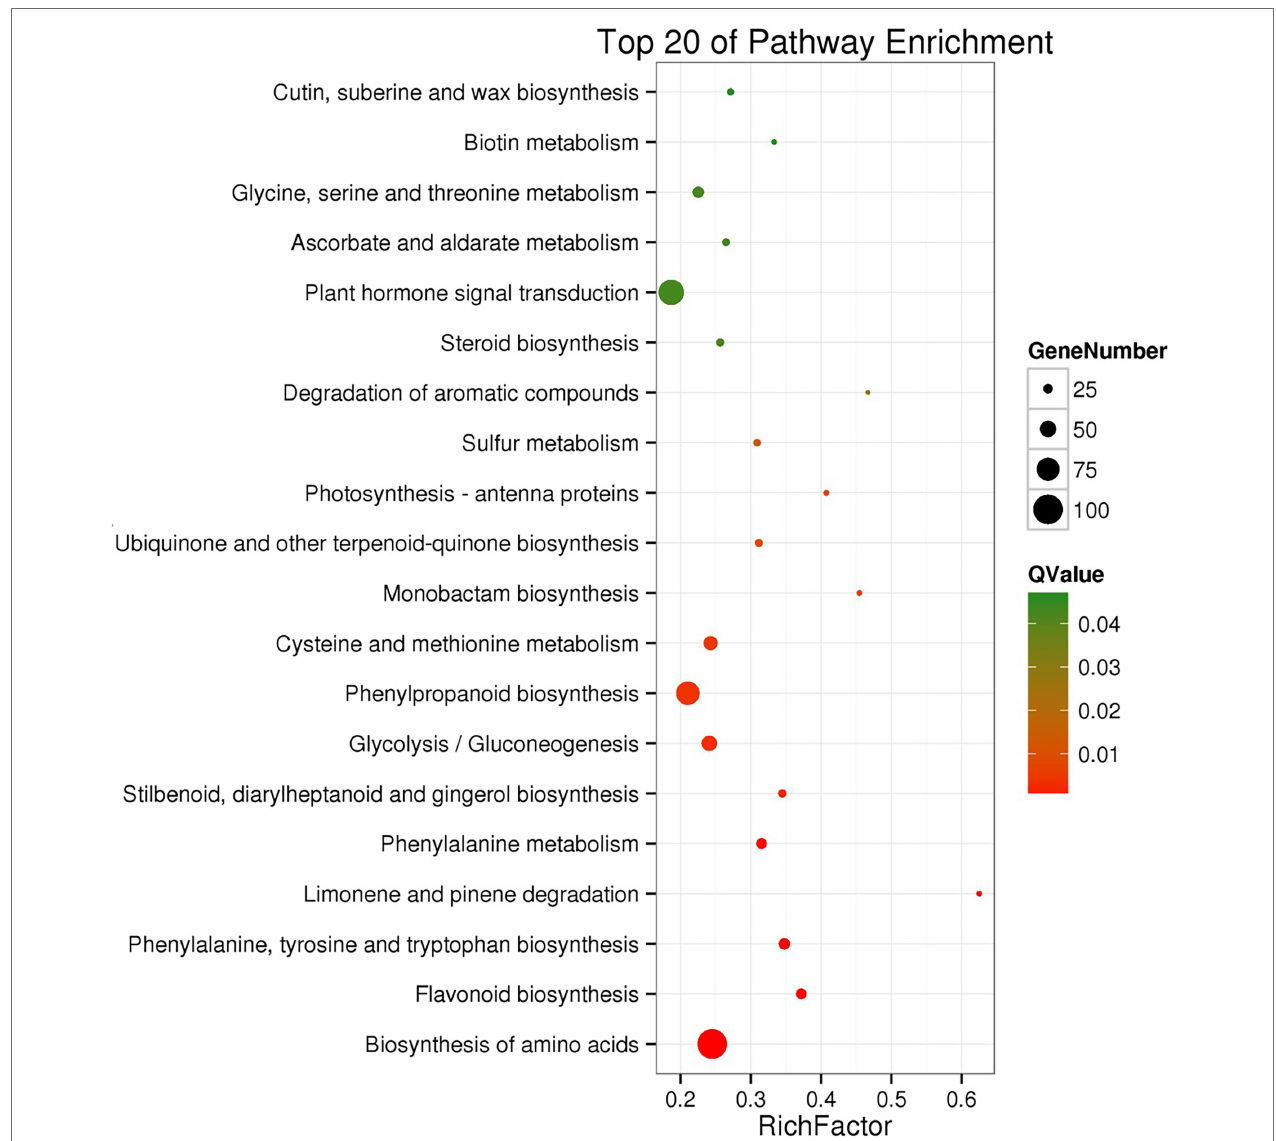
FIGURE 3 | KEGG pathway enrichment of differentially expressed genes after cold treatment. The solid circles represent differentially expressed genes located in the pathway. The larger of the solid circle represents the RichFactor enrichment level of the class. The Q -value is a value of p after a multiple hypothesis test correction from 0 to